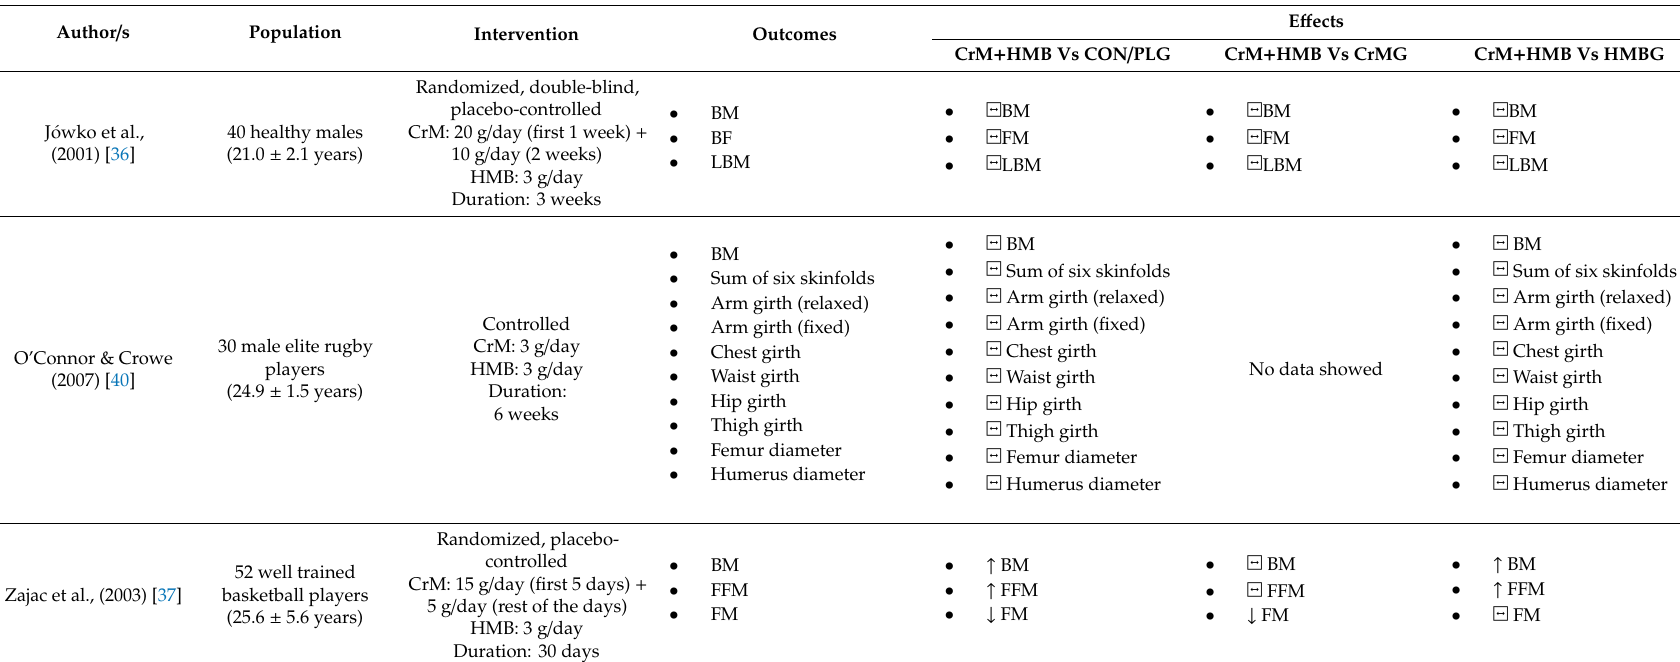
Table 2. Summary of studies included in the systematic review that investigated the e ff ect of CrM plus HMB on body